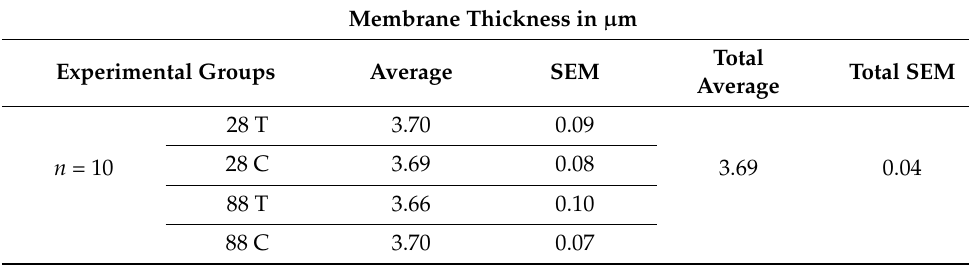
Table 1. Descriptive statistics for membrane thickness values for all sample groups, with SEM (Standard Error of Mean). The numbers 28 and 88 stand for the age of the donor which the dermal fibroblast cells were harvested from. C = Control Group and T = Training Group.